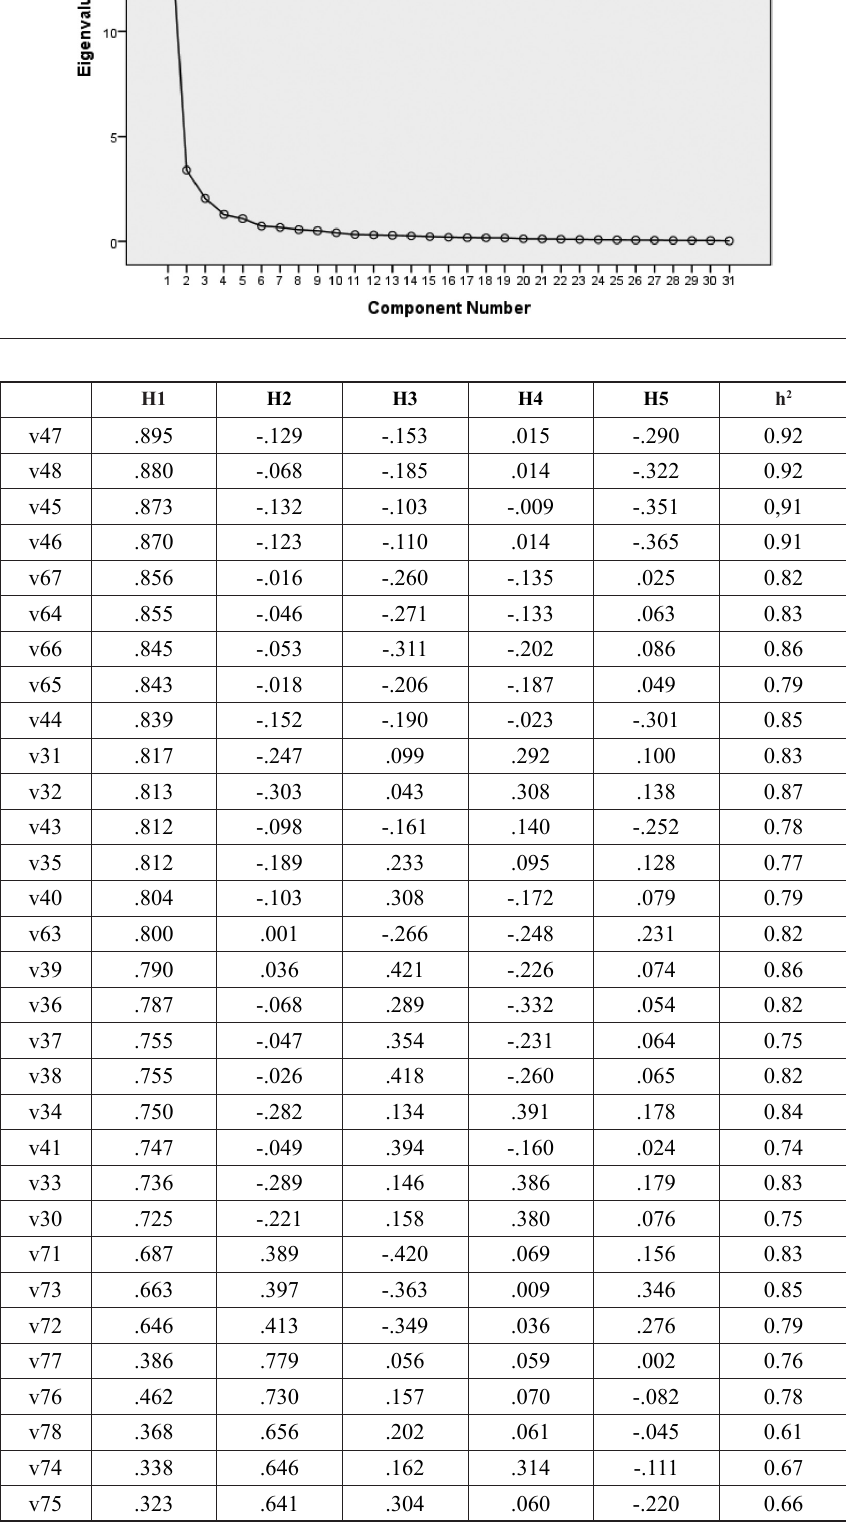
Table 4. Structure of main compo - nents (H), communalities (h2) of students’ entrepreneurial inten -